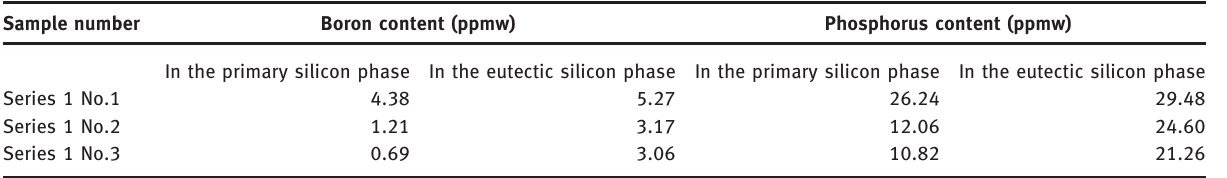
Table 4: Boron and phosphorus contents in the primary silicon phase and the eutectic silicon phase. Sample number